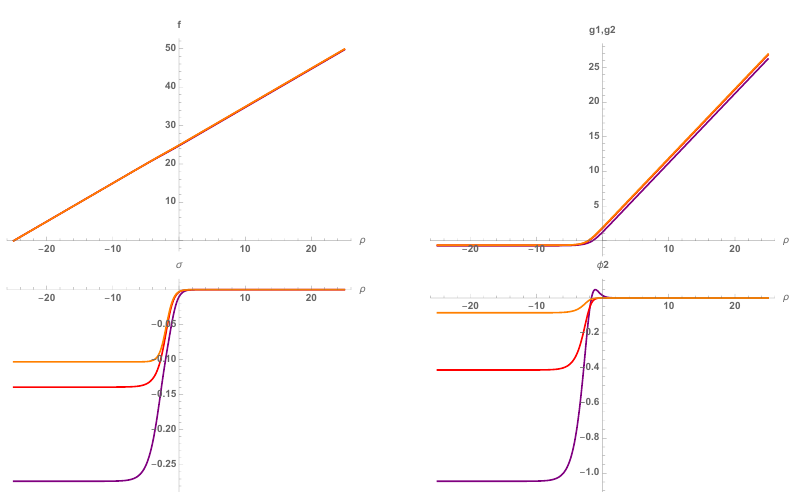
Figure 2 . Numerical black hole solutions with m = 1 = 2 and g 1 = 3 m . For the magnetic